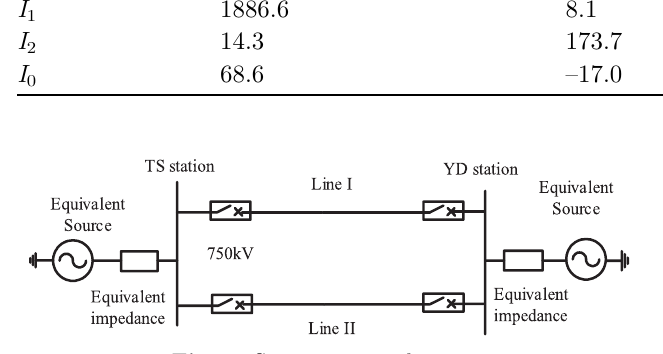
Fig. 2. System wiring diagram.